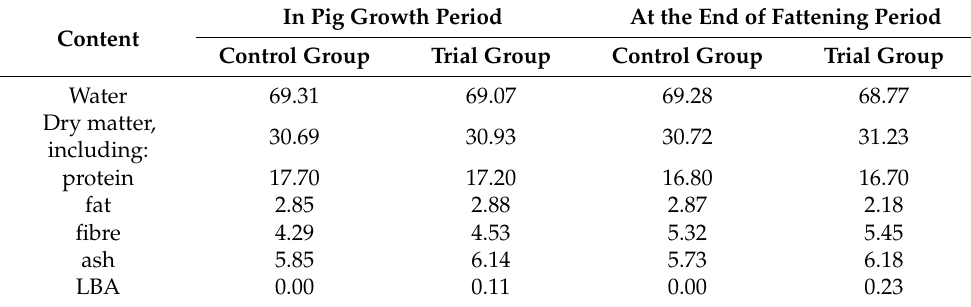
Table 1. Chemical composition of feed (kg per 100 kg of